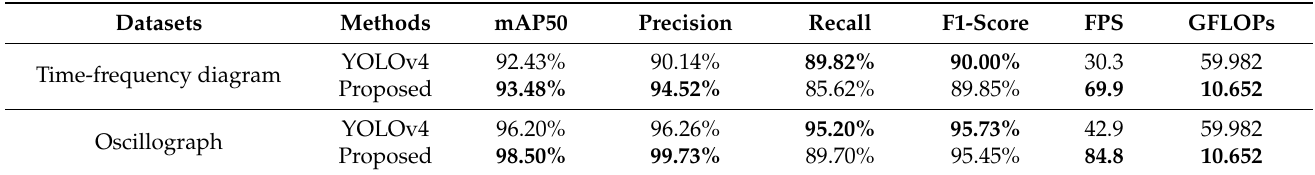
Table 2. Test results of different datasets (confidence threshold is 0.5 and IOU threshold is 0.5).